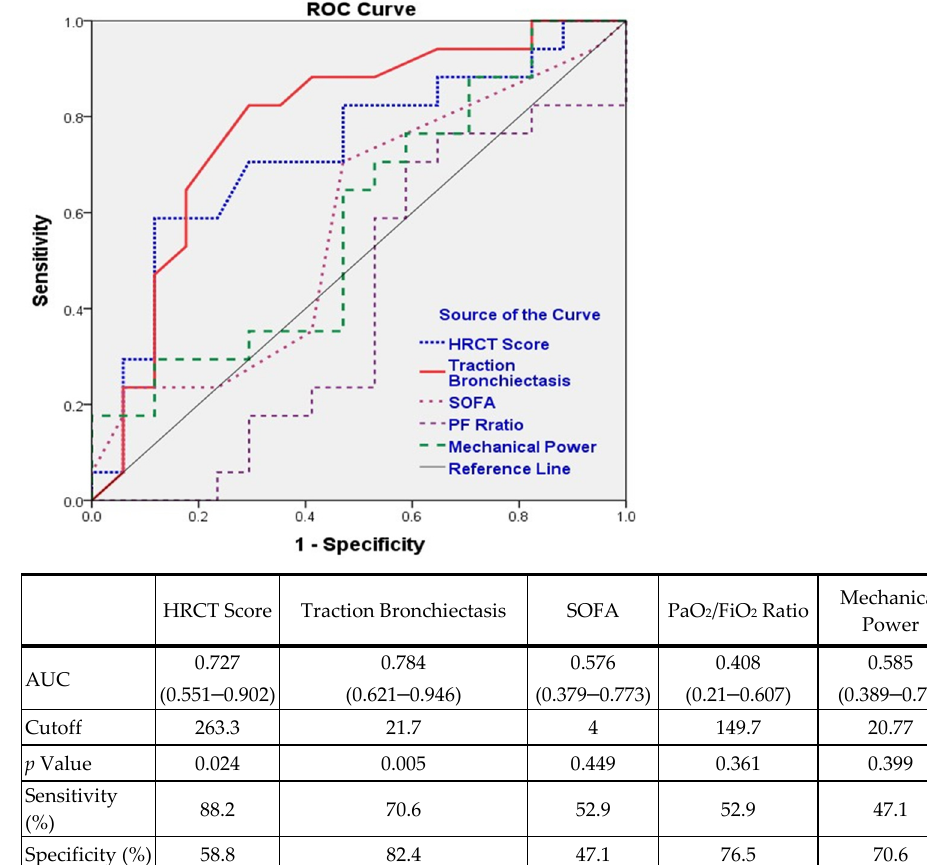
Figure 3. Receiver operator characteristic (ROC) curve of the HRCT score, traction bronchiectasis, SOFA score, PaO 2 /FiO 2 ratio, and MP.